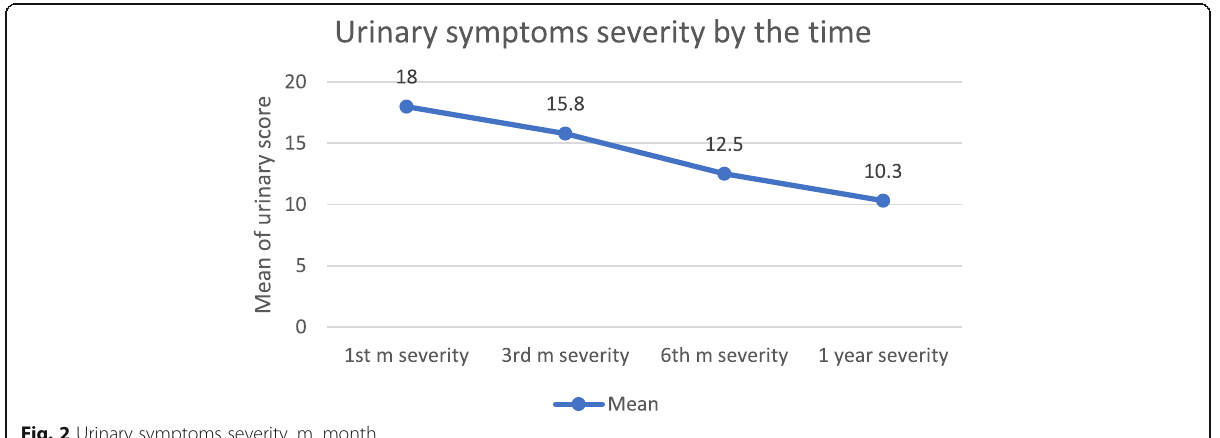
Fig. 2 Urinary symptoms severity. m, month